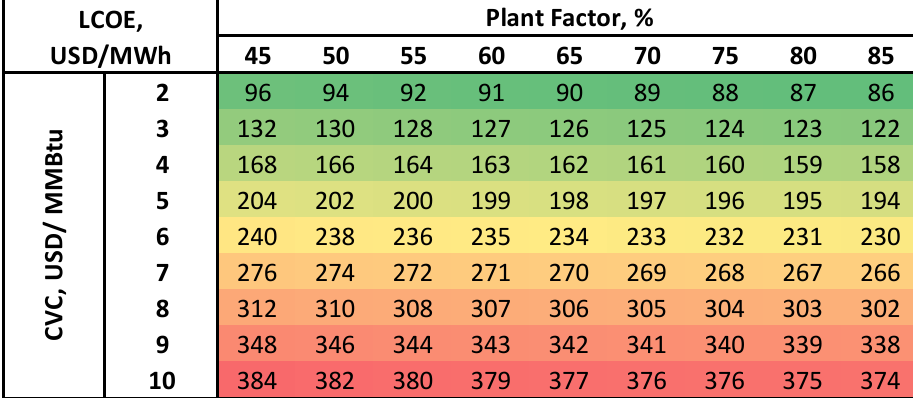
Figure 10. LCOE of a gas plant according to plant factor and variable fuel cost (CVC) in a range of 72 and 359 USD/MWh. The color scale highlights the lowest LCOE in green and the highest LCOE in red.